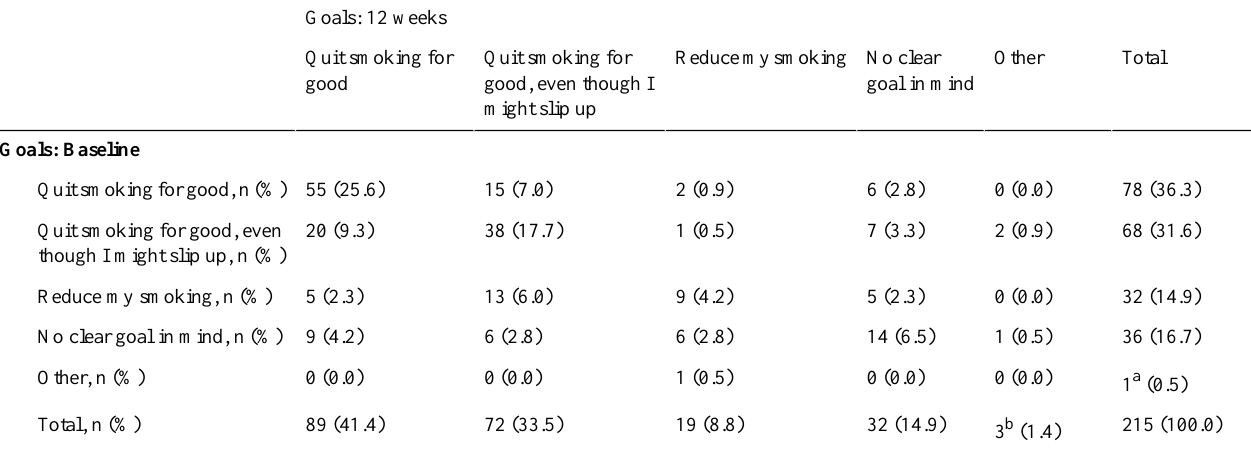
Table 6. Participant goals at baseline (rows) and 12 weeks (columns), match-paired analysis (N=215). Goals: 12